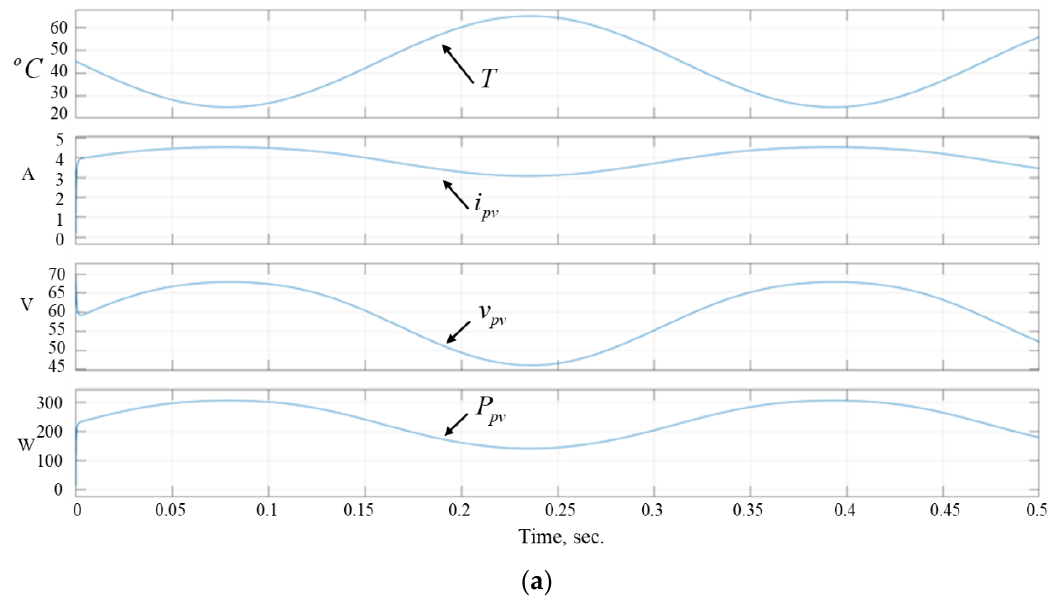
Figure 13. Simulation results for the sudden changes in the solar irradiation. The next simulation is for the condition of continuous variations in the ambient temperature at the solar irradiation of 1000 W/m 2 as follows: T = T 0 + ∆ T , T 0 = 25 ◦ C, ∆ T = 40 sin ω t ( ◦ C ) , ω = 5 rad/s. The simulated results are shown in Figure 14. As can be seen in Figure 14a, the PV array’s output current, voltage, and hence the output power are varied due to the variations in the ambient temperature. The output power of the PV array can also reach the maximum value of about 310 W. The corresponding MPPT control signals of the tracking error e , neural network output ∆ ˆ x , the nominal value x 0 , and the sum of x 0 and ∆ ˆ x are also shown in Figure 14b. As can be seen, the signal of the sum of x 0 and ∆ ˆ x can track the output current of the PV array very well, so that the tracking error is convergent to be zero despite the variation in ambient temperature.